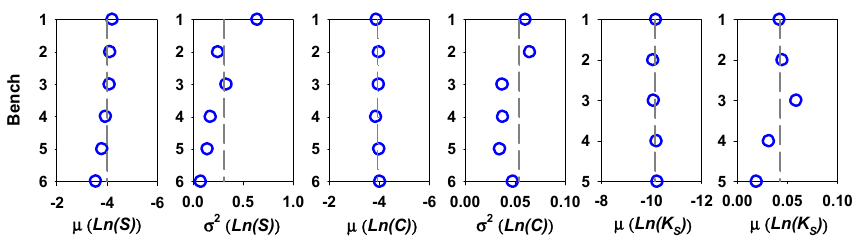
Figure 4. Mean ( µ ) and variance ( σ 2 ) of Ln(S) , Ln(C) , and Ln(K S ) from the deconstruction samples calculated by deconstruction bench. Overall mean and variance shown with dashed line. PSD analysis was conducted for samples from benches 1 to 5 only. Bench 1 was at the top of the test pile; bench 6 was at the bottom.